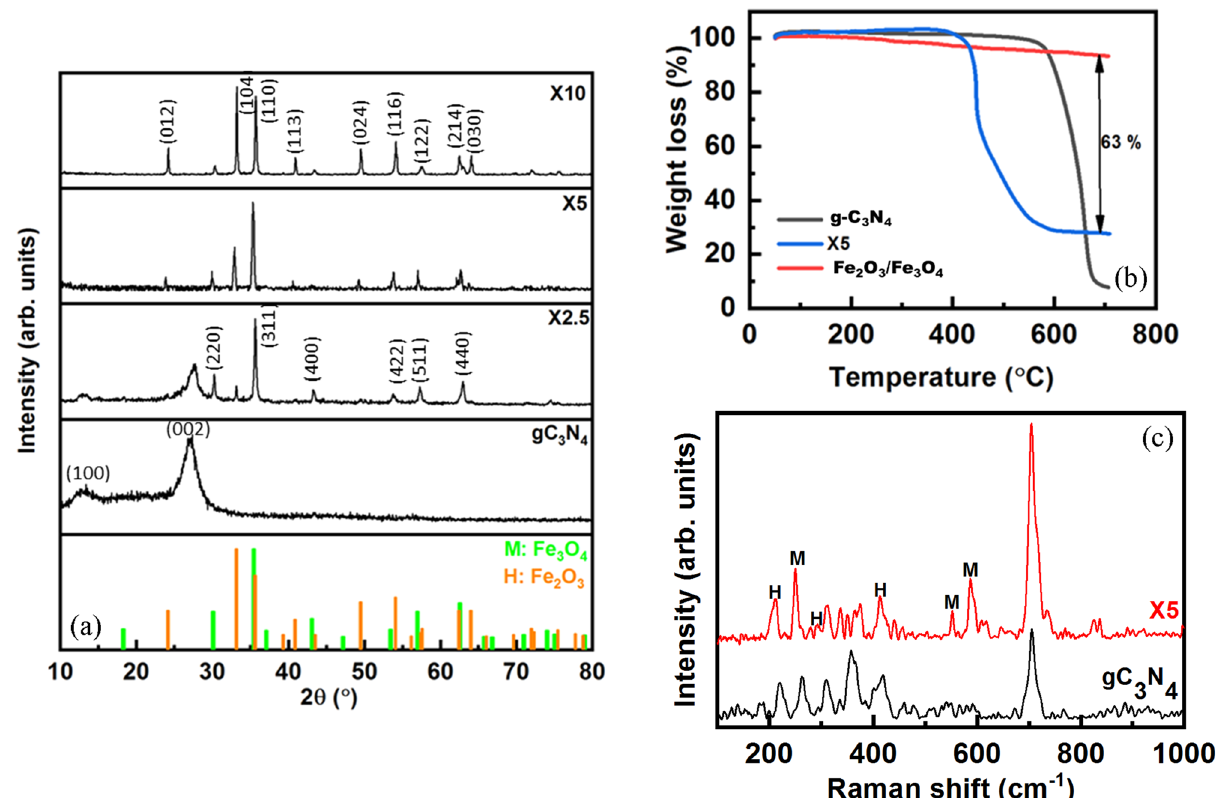
Figure 1. ( a ) XRD patterns, ( b ) TGA curves, and ( c ) Raman spectra of the pristine gC 3 N 4 powders and the X2.5, X5, and X10